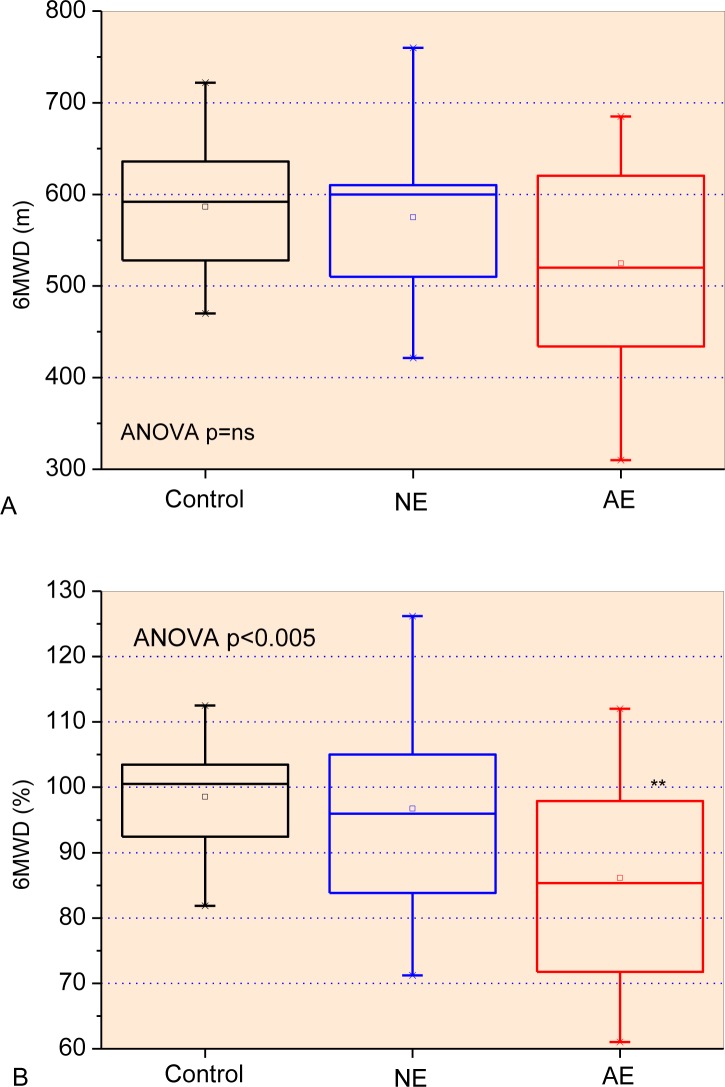
Functional exercise capacity analysis describing the six-minute walk distance (A) predicted percentage (B), initial (C) and final (D) Borg Scale among the studied groups. Associated parameters are presented in Table 3. The top and the bottom of the box plot represent the 25th- to 75th-percentile values, while the circle represents the mean value, and the bar across the box represents the 50th-percentile value. The whiskers outside the box represent the 10th-to 90th-percentile values. **p<0.01 related to control group.